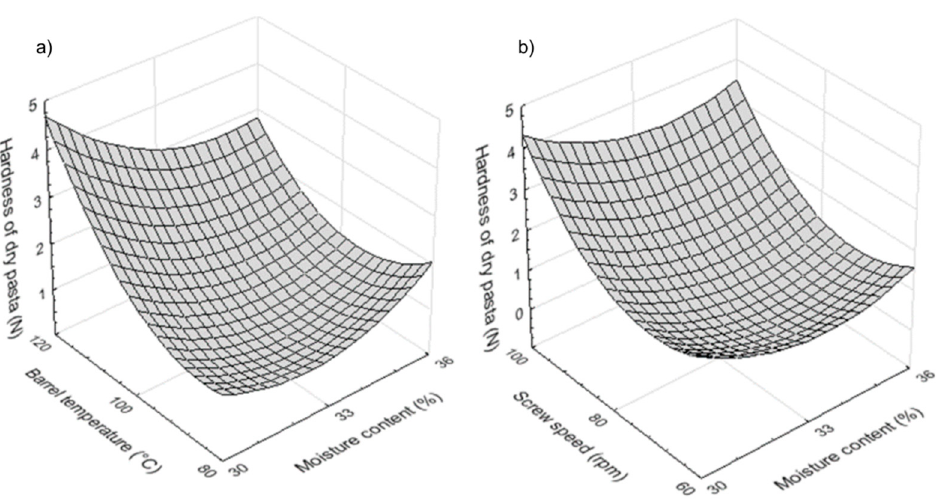
Figure 2. Effect of ( a ) moisture content and barrel temperature and ( b ) screw speed and moisture content on hardness of dry rice-buckwheat pasta.